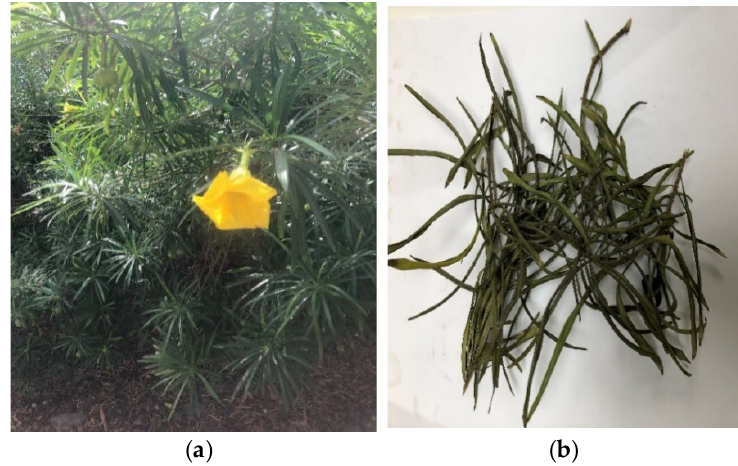
Figure 1. ( a ) Cascabela thevetia plant and ( b ) Cascabela thevetia